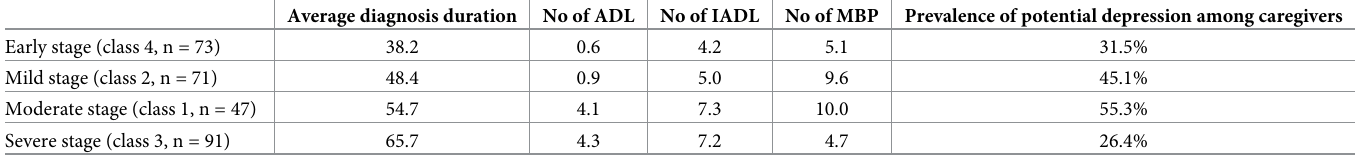
Table 3. Statistics for different stages of dementia in the current